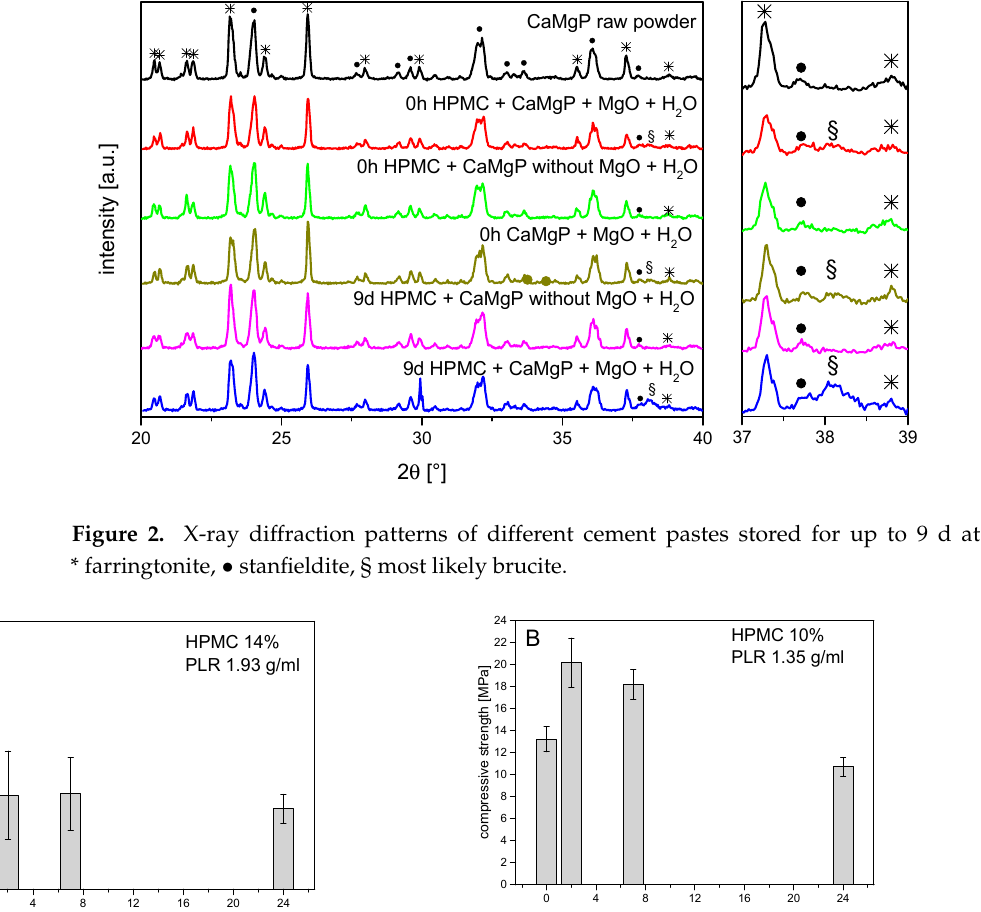
Figure 2. X-ray diffraction patterns of different cement pastes stored for up to 9 d at 37 °C; * farringtonite, • stanfieldite, § most likely brucite.